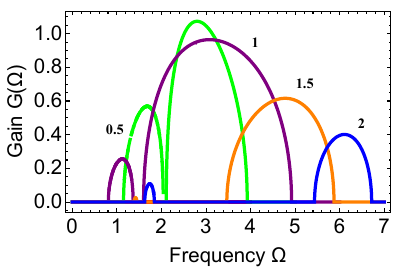
Figure 8. The MI gain spectra in the normal-GVD regime ( σ 1 = − 1) at different values of the asymmetry ratio of the CW state ( η in Equation (8)). Other parameters are P = 1, κ = 1.1, α = 0.1, Γ = 2 and ρ = 0.01.